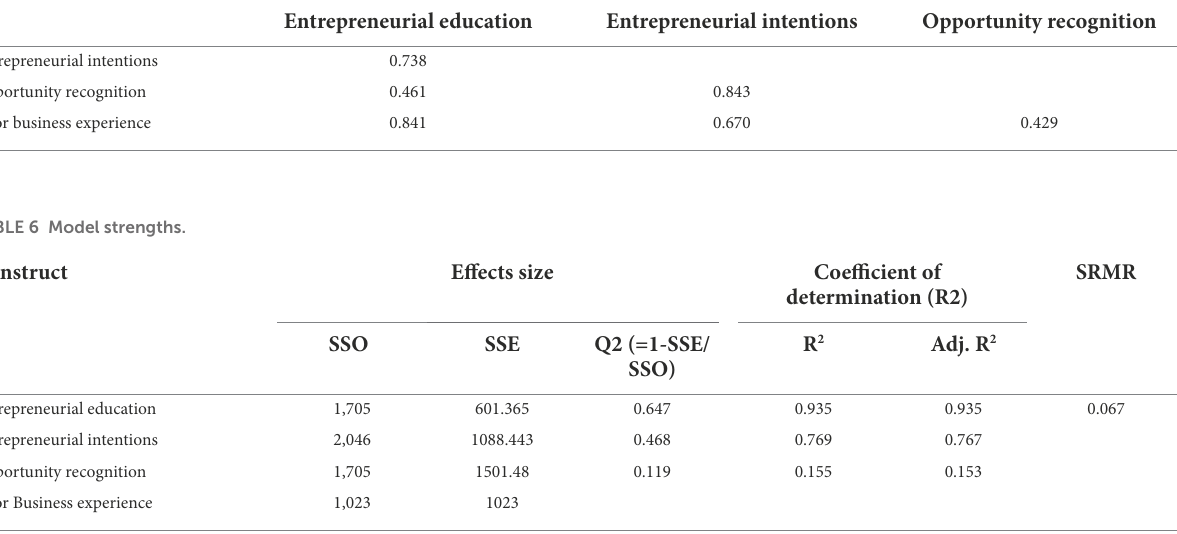
TABLE 5 HTMT (Heterotrait-Monotrait ratio).